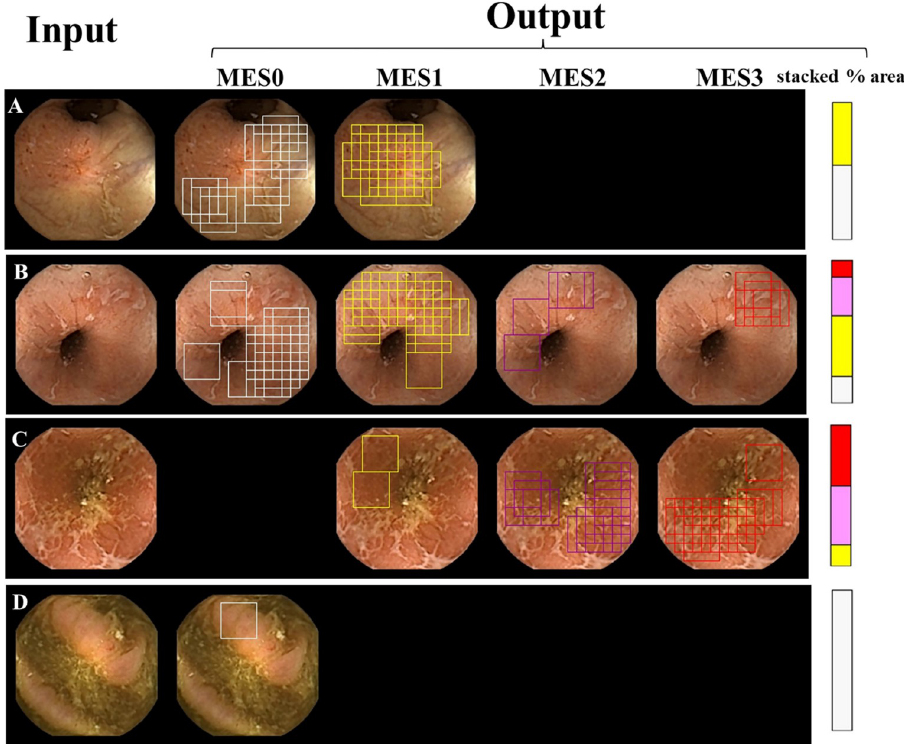
Fig 3. Algorithm for evaluating the severity of a single still picture. Patches trimmed from input images (left columns of A–D) were classified into MES0 (dark gray open square), MES1 (yellow open patch), MES2 (magenta open patch), and MES3 (red open patch). Area0 (area of MES0) is defined by the union of the dark gray open patches. Similarly, area1, area2, and area3 by that of yellow, magenta, and red open patches, respectively. Severity is expressed by the stacked bar graph, composed of % area: white, MES0; yellow, MES1; magenta, MES2; and red, MES3 (right columns of A–D).